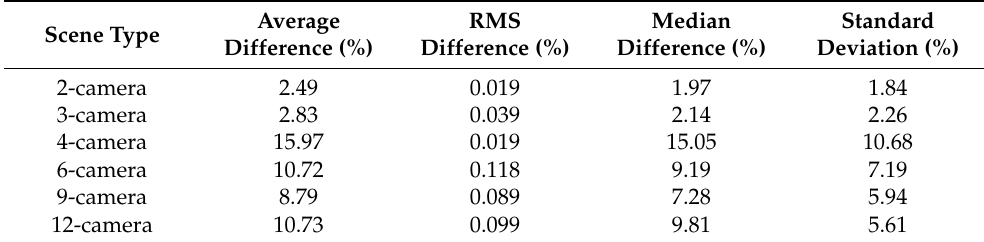
Table 3. Statistics for the differences between predicted and evaluated density under different scenarios with outliers removed.